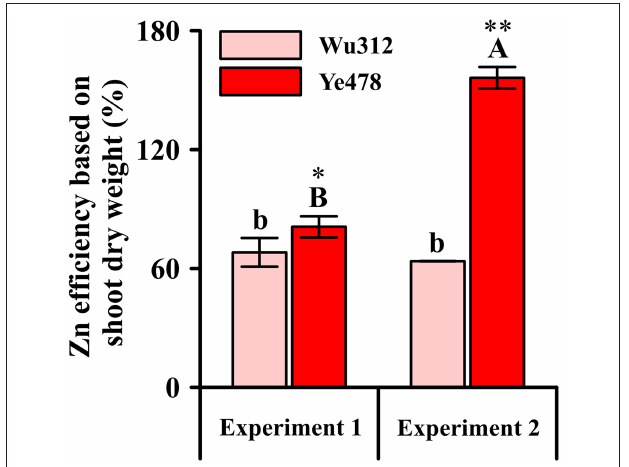
FIGURE 5 | Zn efficiency based on shoot dry weight (%) of Zn-sensitive inbred line Wu312 and Zn-tolerant inbred line Ye478 in Experiment 1 and Experiment 2. Different lowercase and upper letters indicate significant difference ( p < 0.05) of Wu312 and Ye478 among treatments, respectively. * and ** indicate significant difference between Wu312 and Ye478 at p < 0.05 and p < 0.01,